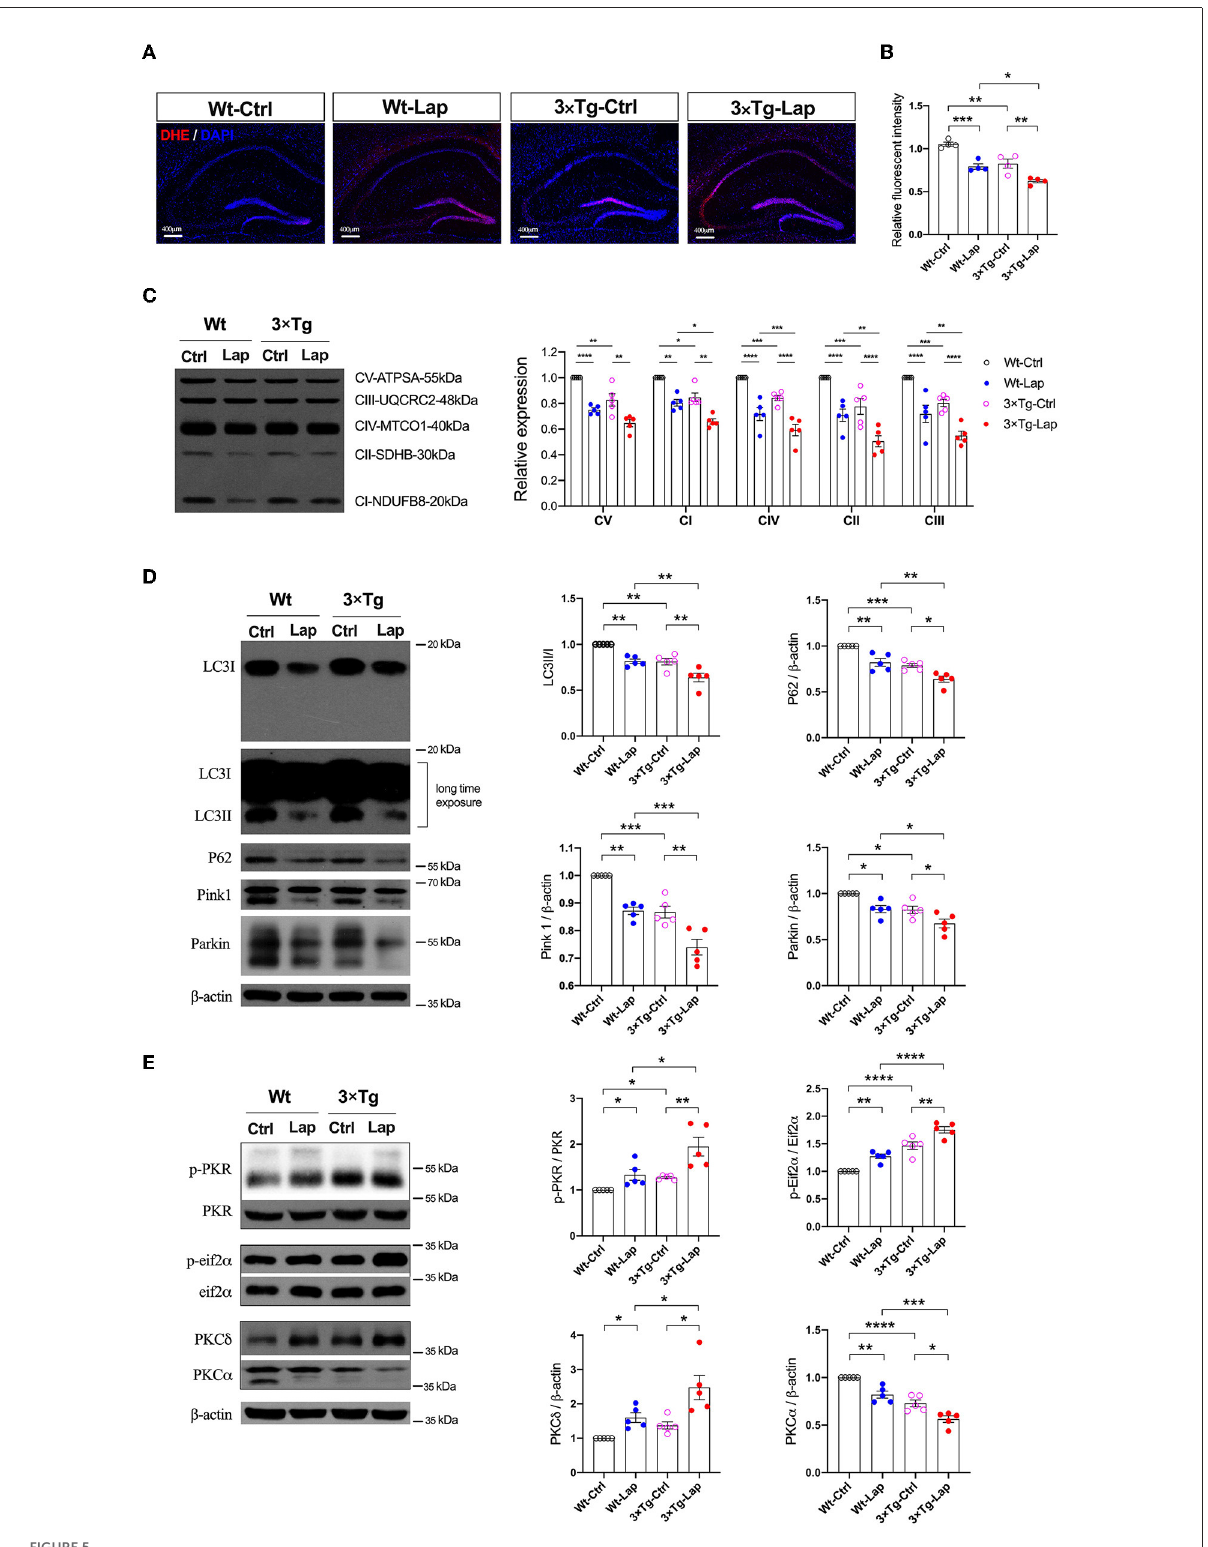
FIGURE5 Laparotomy impaired mitochondria mediated by the activation of PKR. (A) To evaluate the oxidative stress in the CNS, DHE staining was used in the entire hippocampal region following laparotomy in two strains of animals. Representative pictures were obtained from three independent experiments. (B) Mitochondria membrane potentiation was determined by JC-1 assay in the isolated mitochondria fractions in the hippocampi.